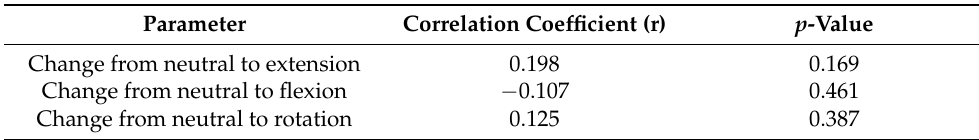
Table 5. Correlation coefficient of peak inspiratory pressure changes to intracuff pressure changes with head